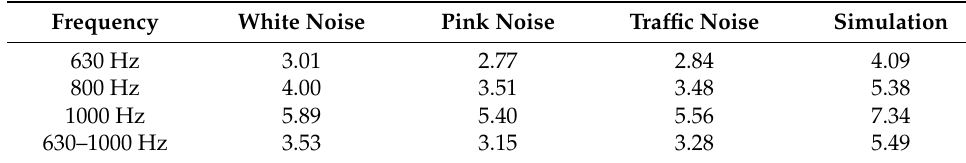
Table 9. The ∆ LA eq of experiments for three noises and simulations. Frequency White Noise Pink